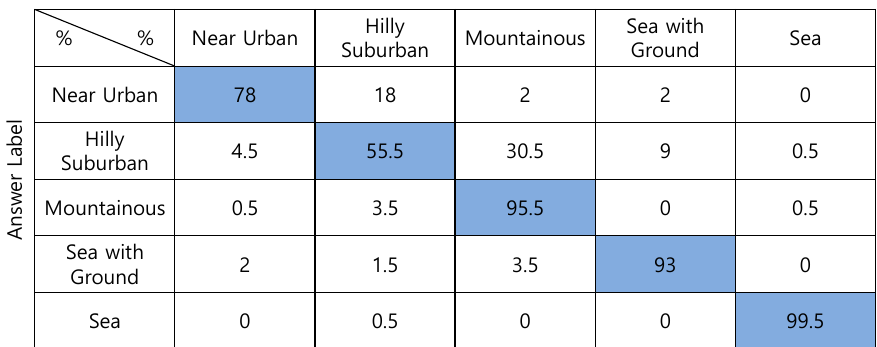
Figure 10. Confusion matrix of the correlation-based classification in [22].